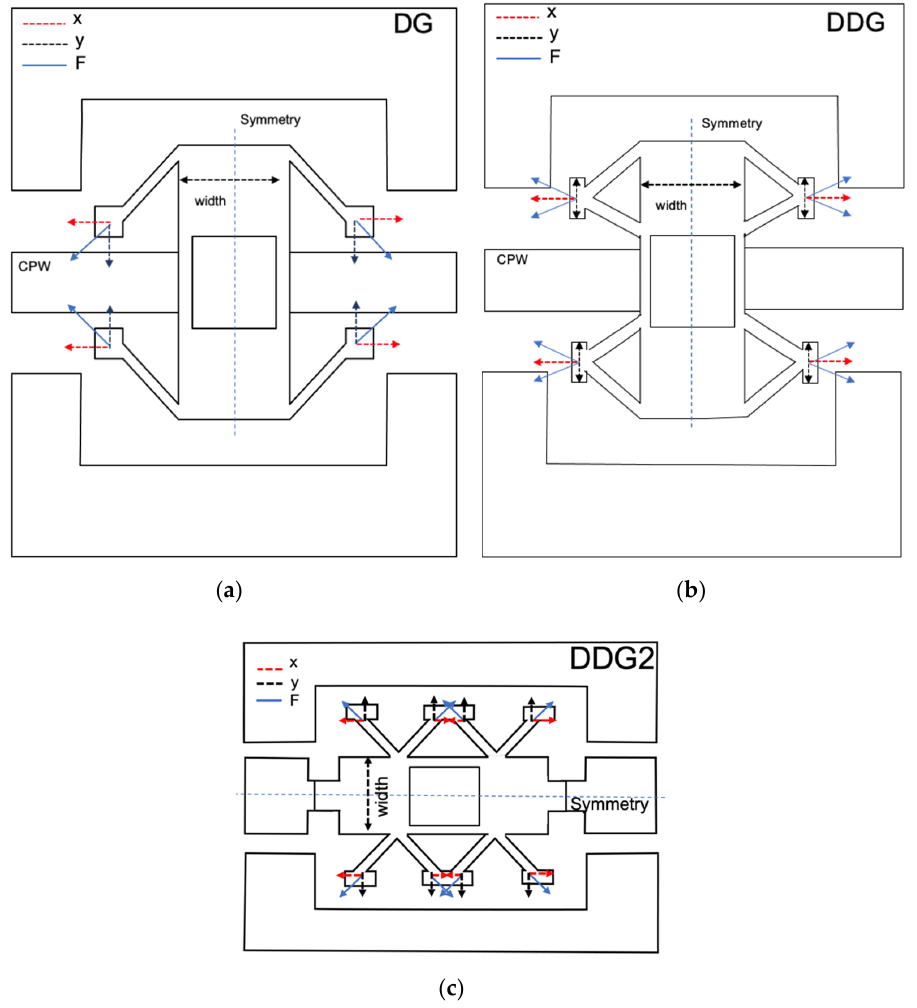
Figure 3. Comparison of new proposed mechanical suspensions (DDG, DDG2) with former DG suspension. ( a ) DG; ( b ) DGG; ( c ) DGG2.